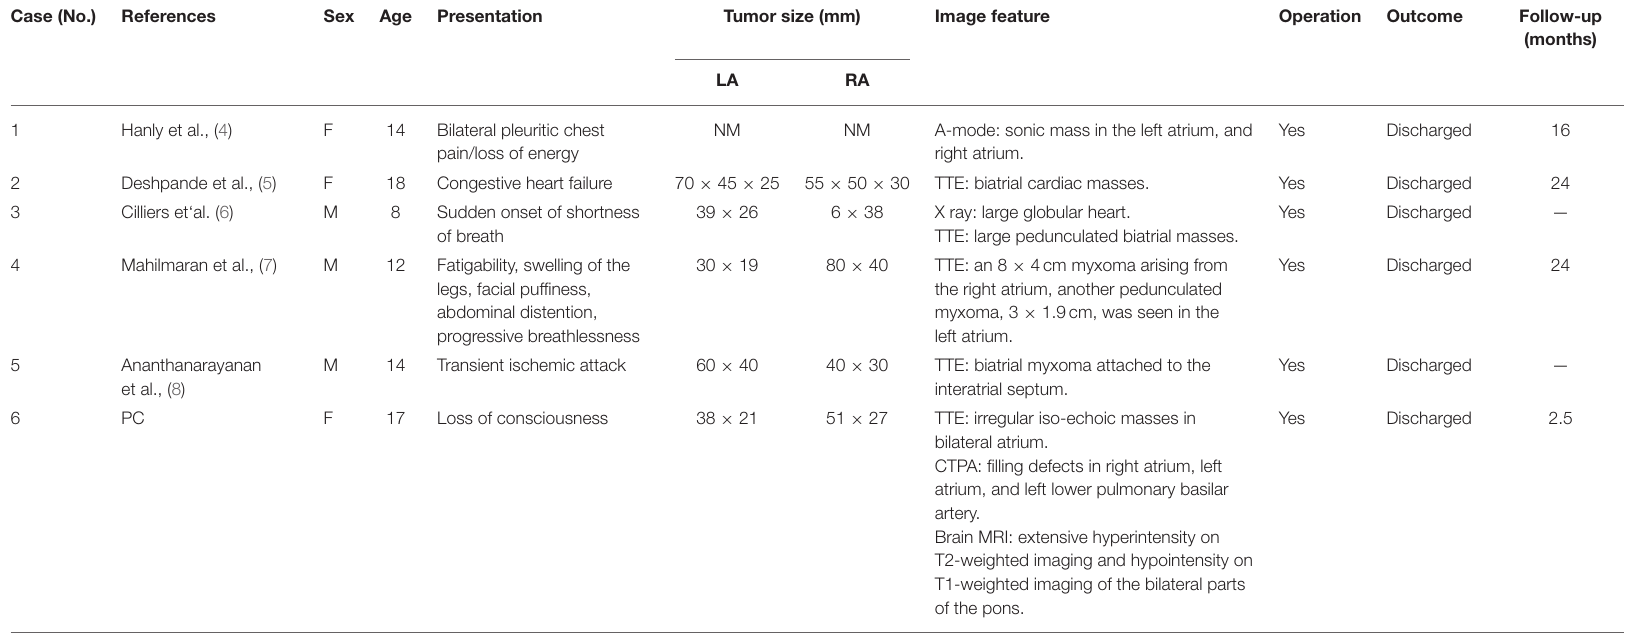
TABLE 1 | The cases of biatrial. myxoma in children and adolescent patients from the literature review. Case (No.)